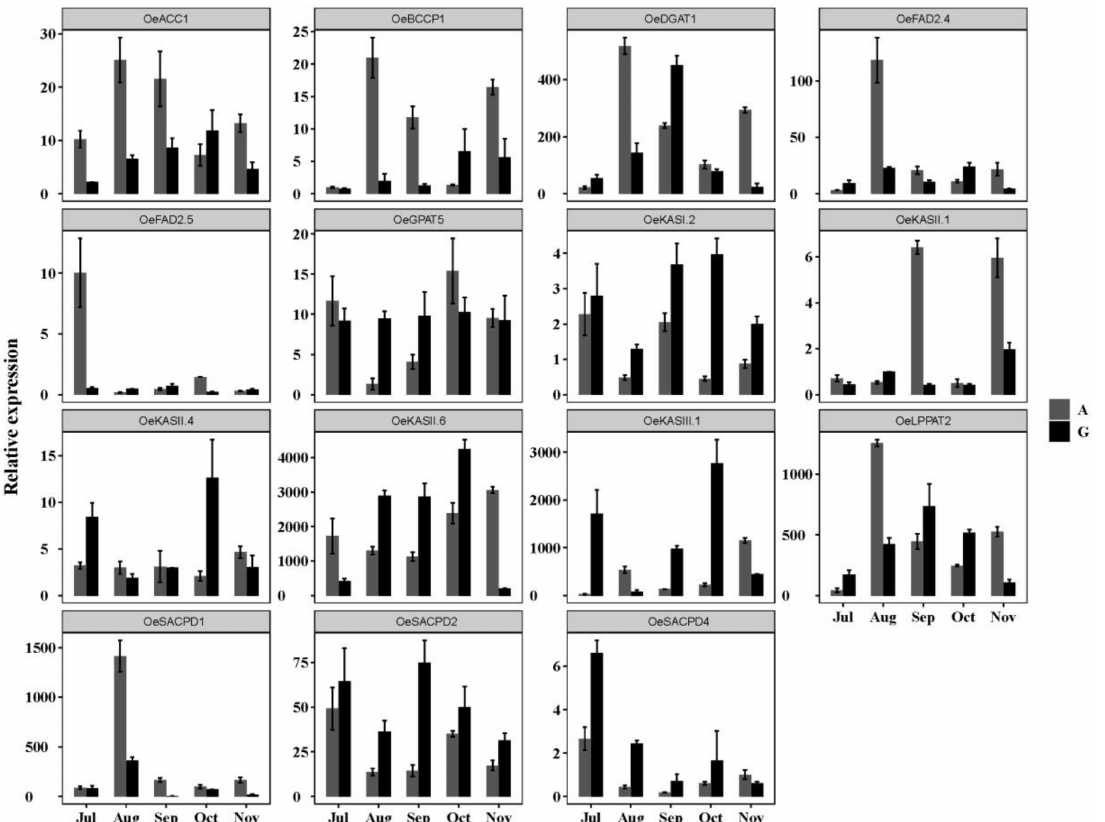
Figure 9. Expression levels of 15 LPG genes during fruit development in di ff erent varieties. qRT-PCR was used to detect the expression level of the LPG gene in fruits of di ff erent varieties from July to November. A represents ‘Arbequina’, and G represents ‘Grossa’. The error bars indicate the mean ± standard deviation (SD) of three